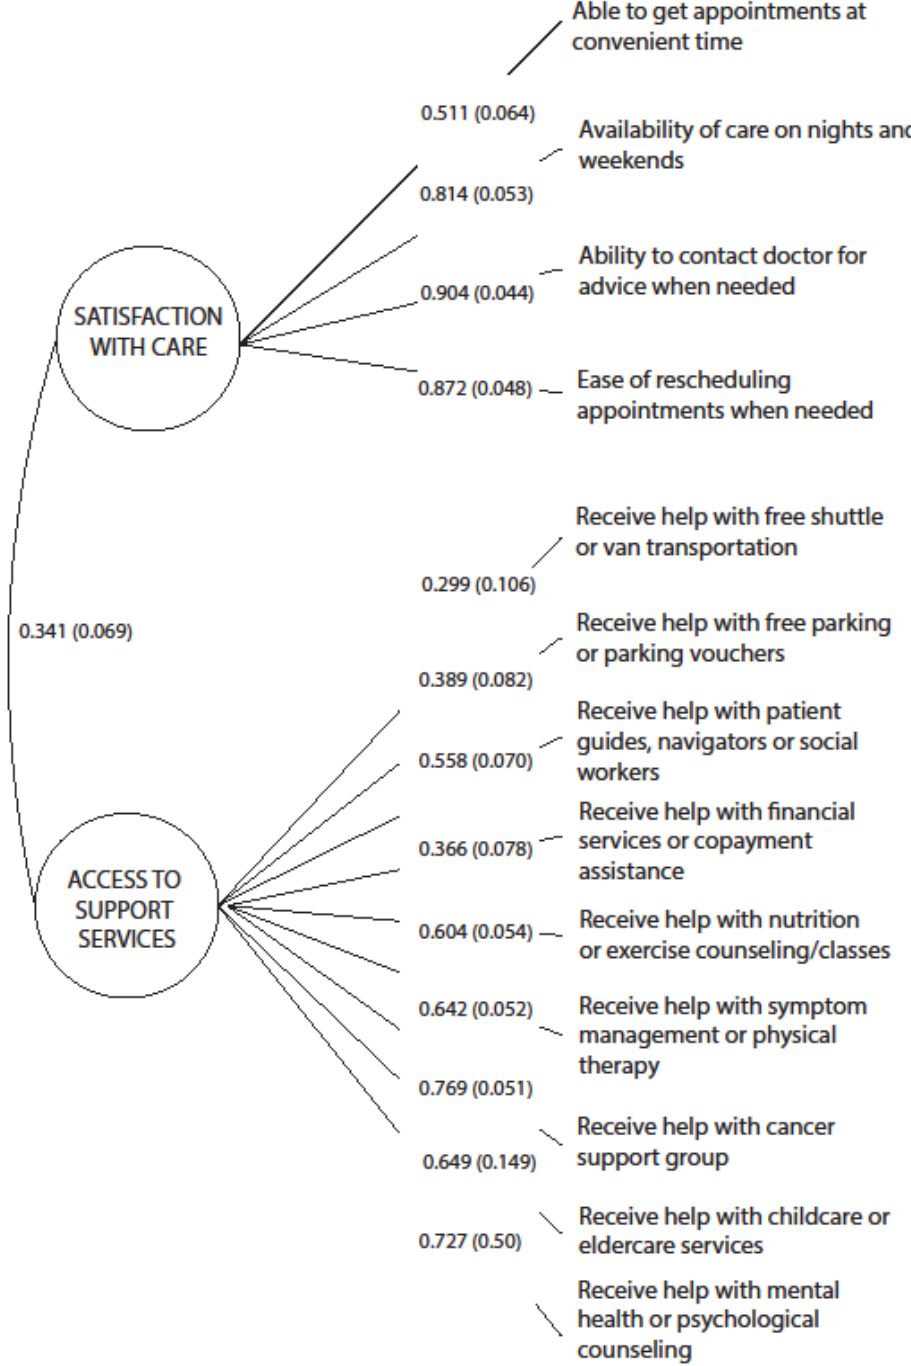
Standardized factor loadings linking each variable to their respective factors are presented in Figure 3.